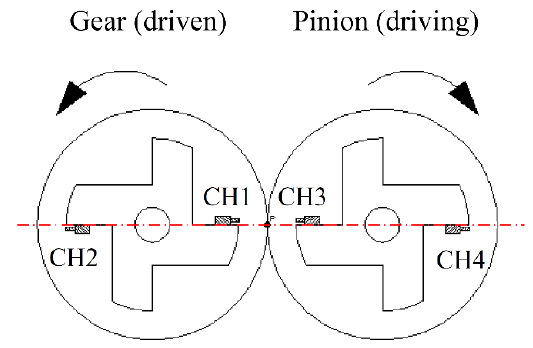
Figure 9. Illustration of the four mounted accelerometers.